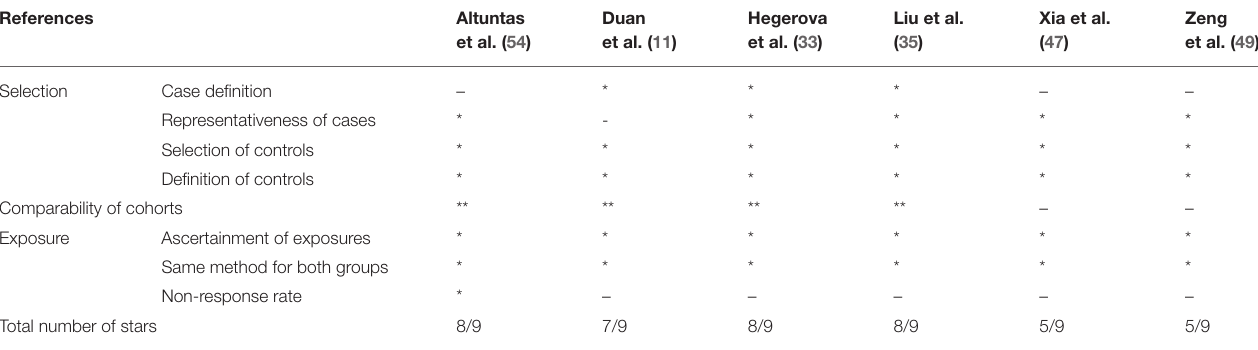
TABLE 2C | Quality assessment for case–control studies included in the